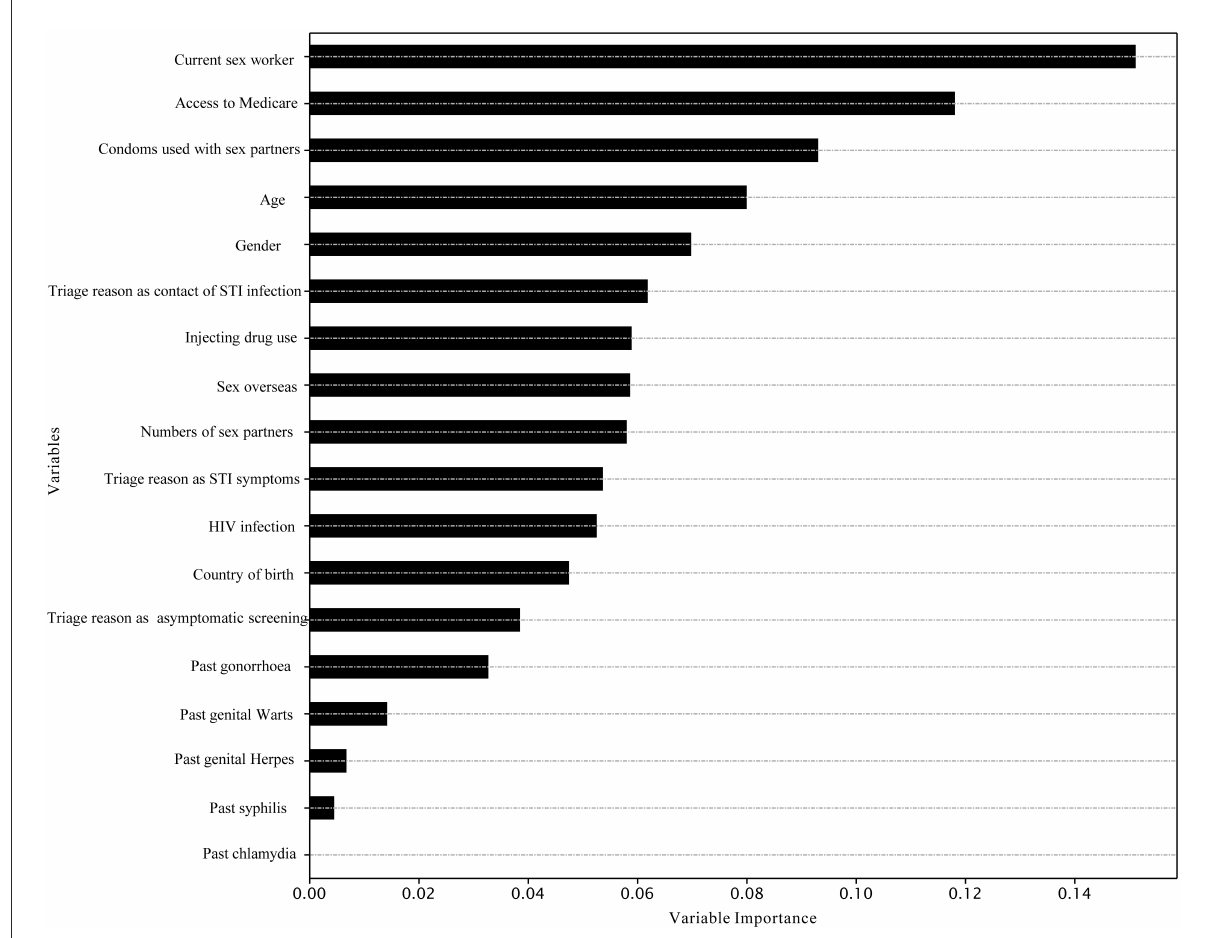
FIGURE1 Variable importance in the prediction of chlamydia re-testing within 1 year among heterosexuals by